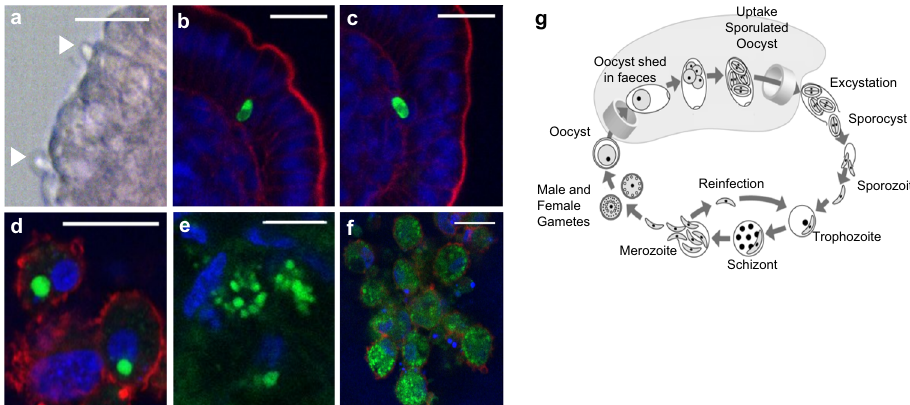
Fig. 10 Chicken enteroids as a model for host – protozoal interactions. a Bright fi eld image of sporozoites (closed arrow) entering caecal enteroid at 1 dpi. b – f Representative z-axis projections of chicken caecal enteroids whole-mount stained to detect cell nuclei (DAPI, blue), F-actin-expressing brush border (red) after incubation with PKH-67 labelled E. tenella (green). b Sporozoite at 2 dpi within enteroid epithelial cell and c migrating through basement membrane into lamina propria. d E. tenella trophozoite-like structures. e – f Schizogeny within enteroid epithelial cell at 9 dpi. g Schematic diagram of E. tenella lifecycle, source: impextraco.com. Scale bar: a – d , f 20 µ m, e 10 µ m. Images are representative of data from 2 independent experiments each with 2 – 3 technical replicates containing >3